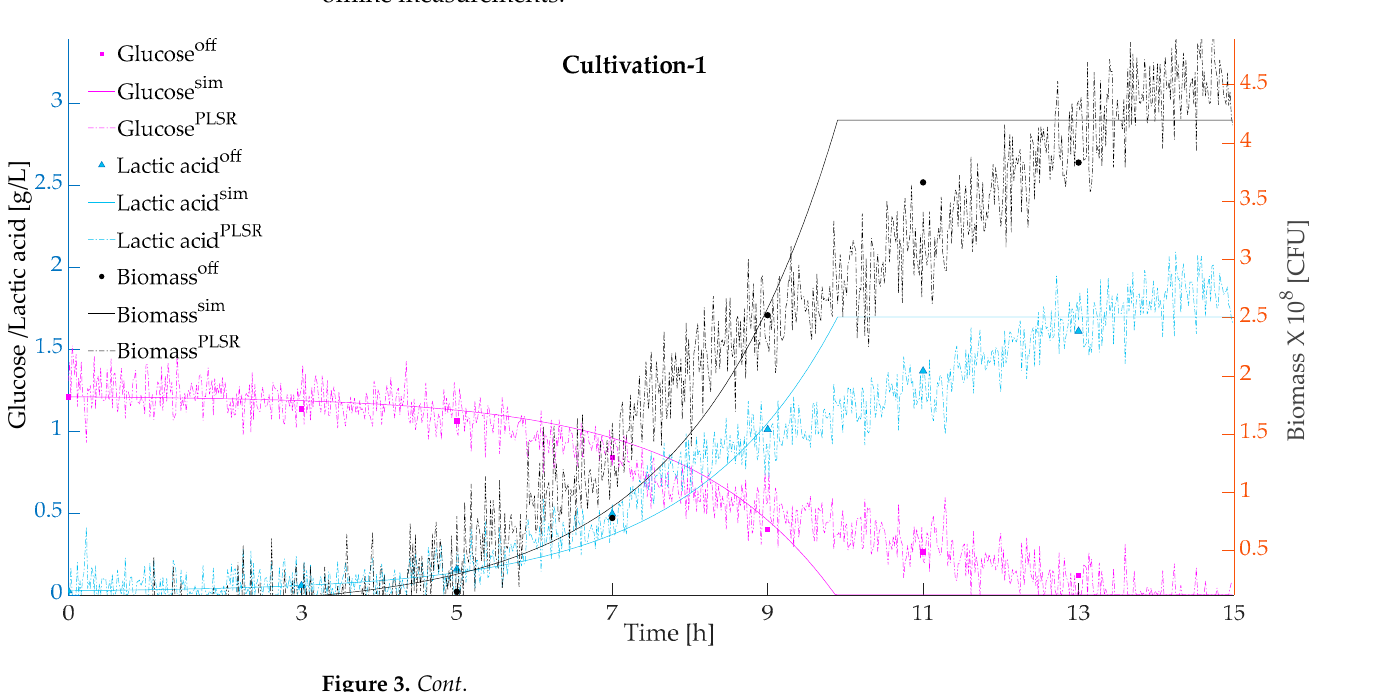
actual offline measurements for the cultivations using a model-based calibration approach. Simulated and predicted biomass, glucose, and lactic acid were plotted against the actual offline measurements.